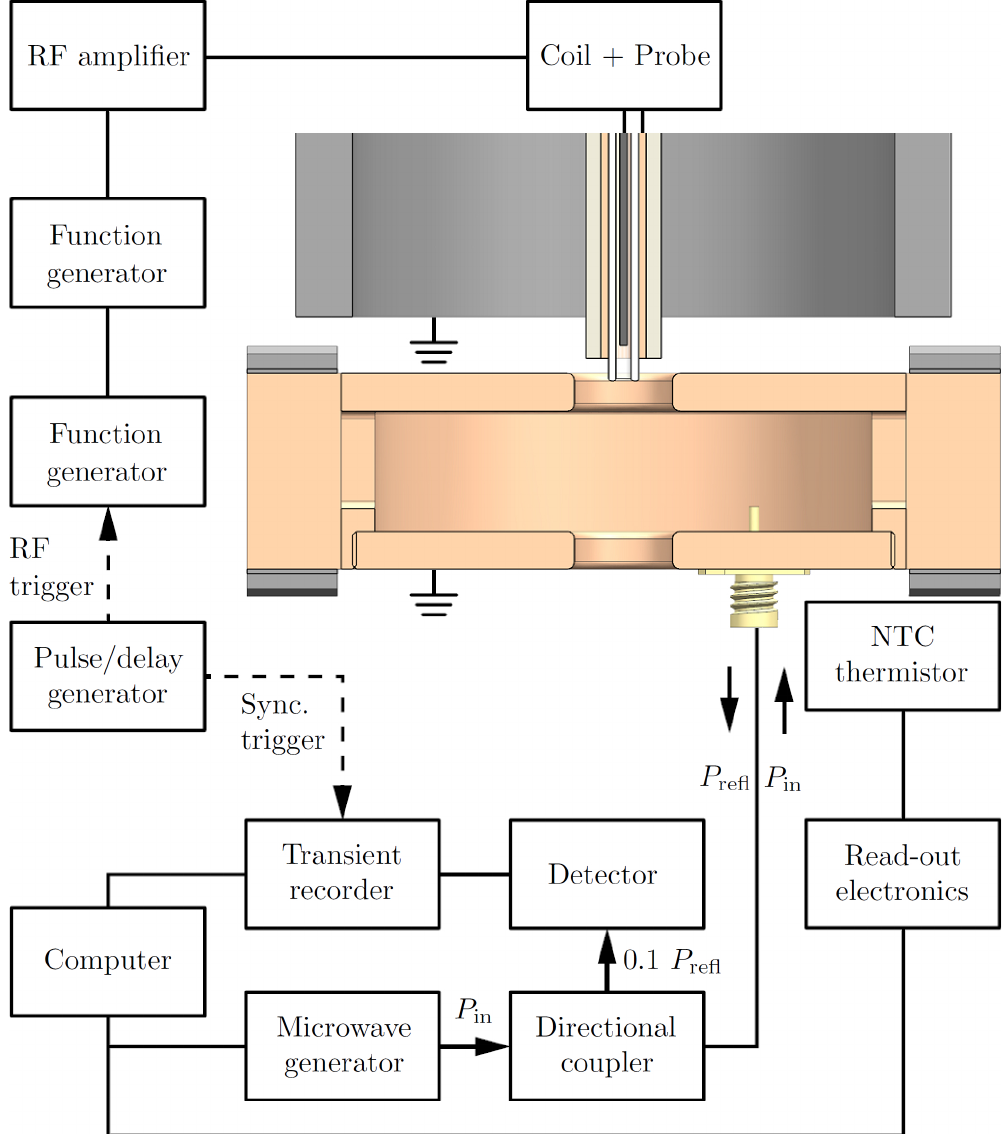
Figure 4. A schematic representation of the experimental setup comprising the plasma source, the resonance cavity, and the control and read-out electronics. B. Platier, T. J. A. Staps, M. van